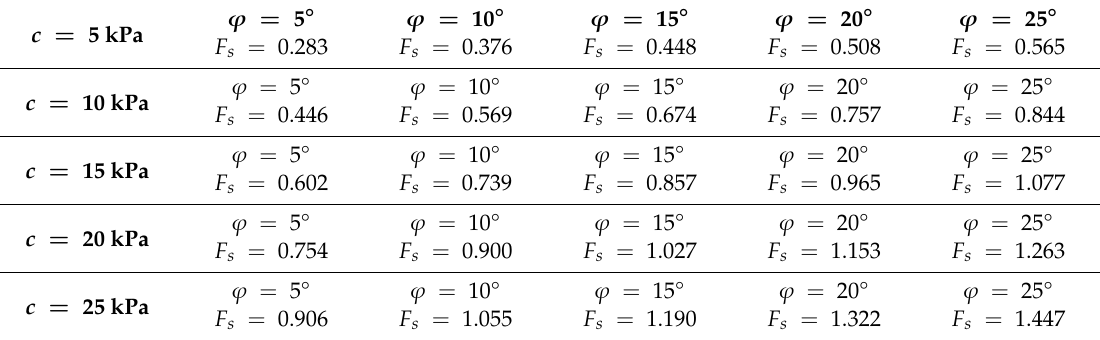
Table 1. Calculated strength reduction factors with 𝐶 = 5 m and 𝐷 = 5 m .